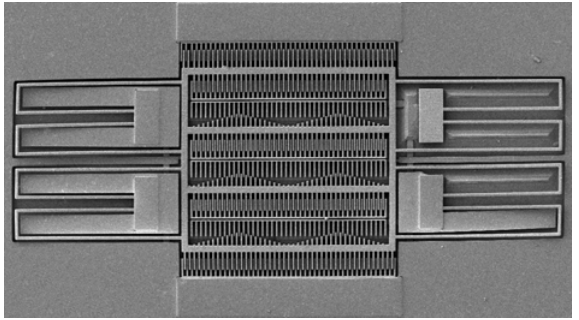
Figure 11. SEM image of the tunable resonator after completion of the